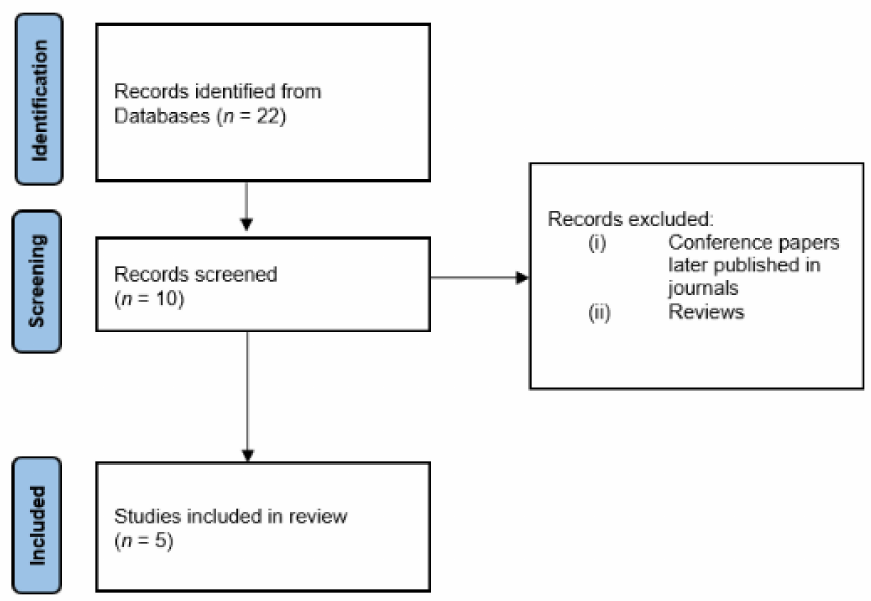
Figure 3. Flow chart of the paper selection for robotic devices.